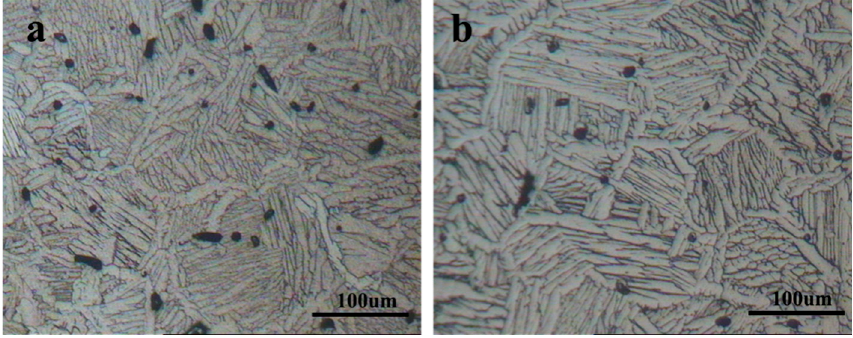
Figure 4. OM images of PM TC4 alloy when sintered at ( a ) 1300 ◦ C, 120 min, 5 ◦ C/min; ( b ) 1300 ◦ C, 240 min, 5 ◦